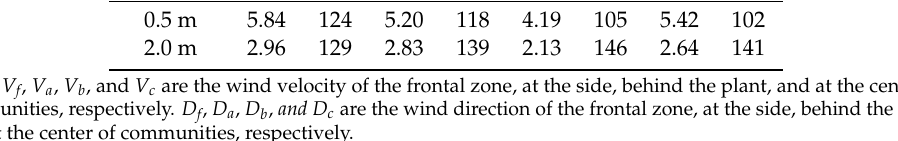
Table 2. Airflow velocity ( V i , m/s) and direction ( D i , ° ) in different layers of H. rhamnoides communities.